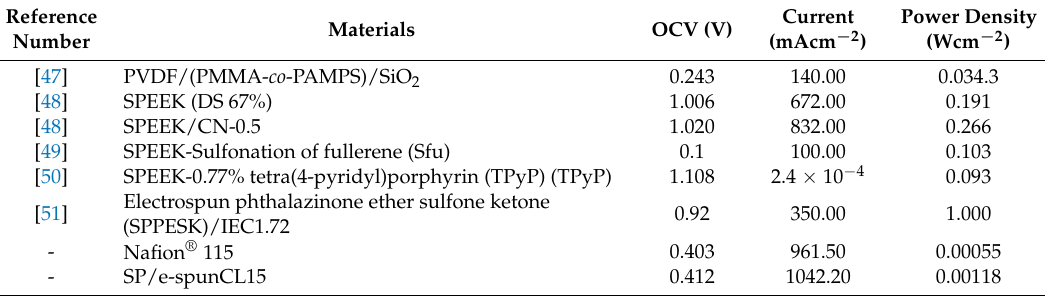
Table 6. Latest DMFC performances based on comparable materials and